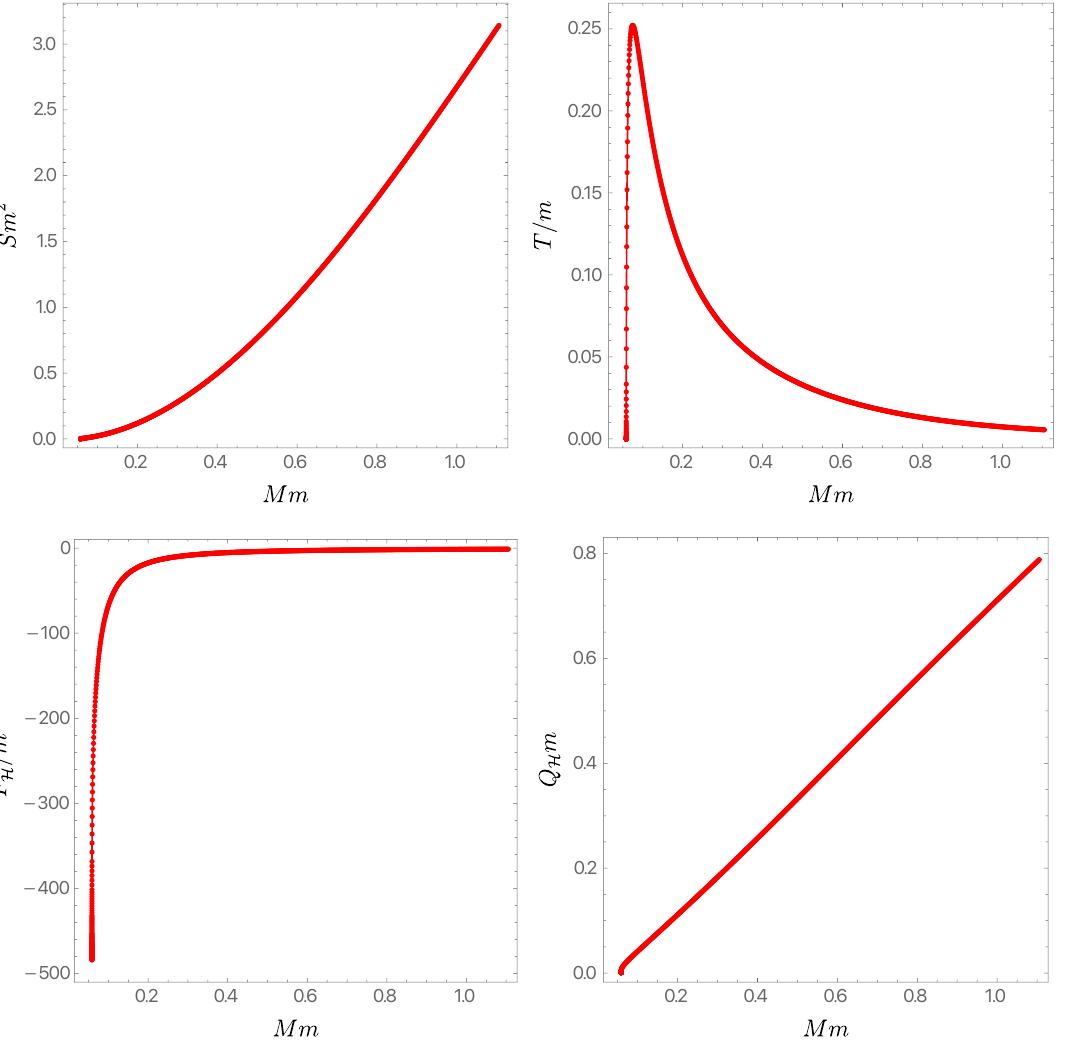
Figure 7 . Physical properties of the hairy black hole with q = m and α = 1 are shown along a line of constant ( Q − M ) m = 5 × 10 − 3 . In the late stages of Hawking evaporation, the black hole is expected to approximately follow such a line with decreasing M